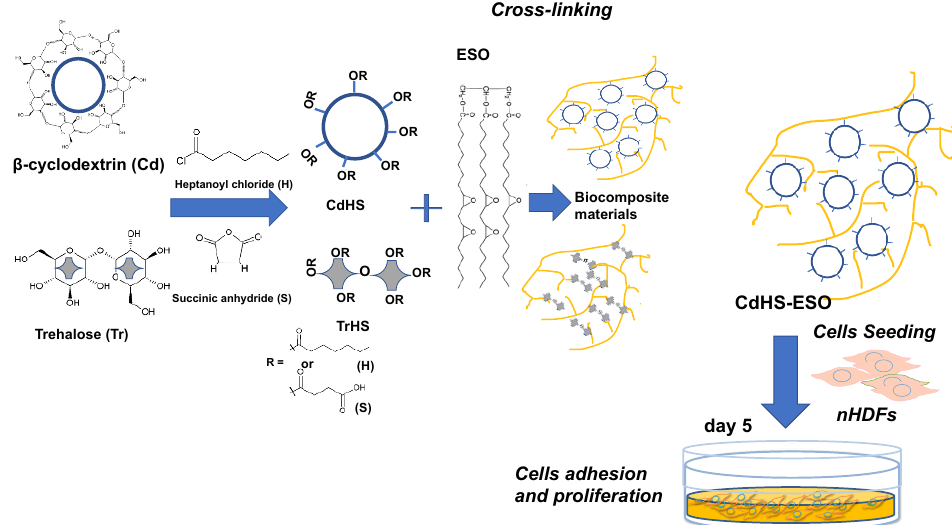
Figure 9. Schematic representation of the CdHS-ESO- and TrHS-ESO-based composite materials pro- duction and the cell scaffolding property of CdHS-ESO. H, heptanoyl chloride; S, succinic anhydride; CdHS, β -cyclodextrin with ∼ 6 H units and ∼ 8 S units; TrHS, trehalose with ~4 H units and ~3 S units; nHDFs, neonatal human dermal fibroblasts (inspired from Zhang, Q. et al.) [112].